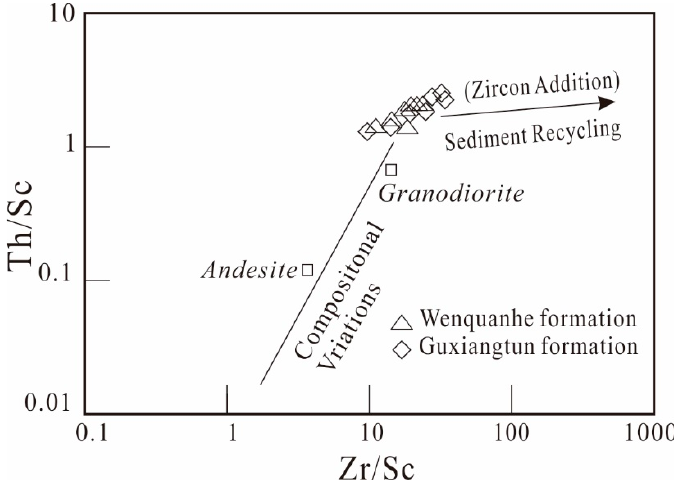
Figure 7. The Th/Sc vs. Zr/Sc ratios plot for the Guxiangyun and Wenquanhe Formations.